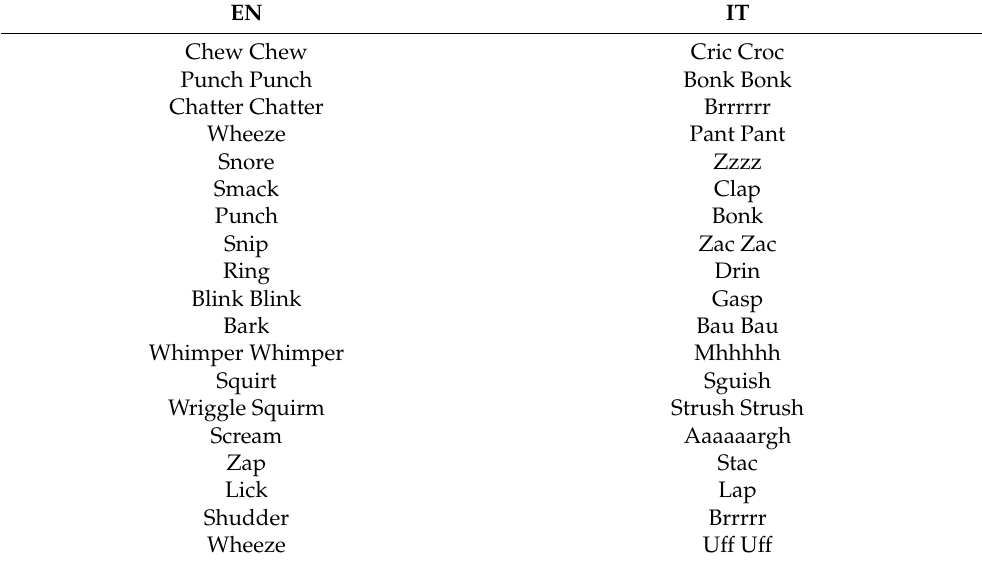
Table 4. List of ‘total substitution’ instances.